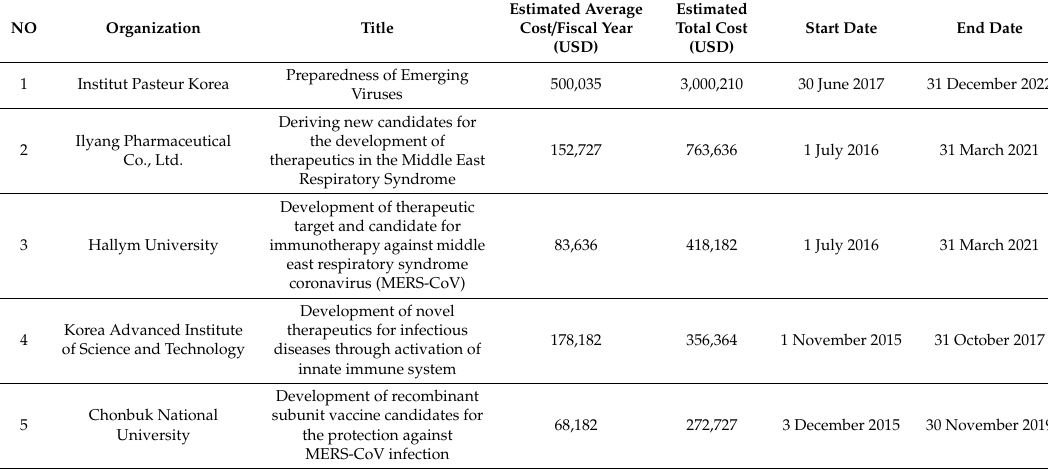
Table 12. Studies on the design of antiviral agents based on the structure and function of viral and human receptor proteins in Korea (Sub-Cluster 2-2).